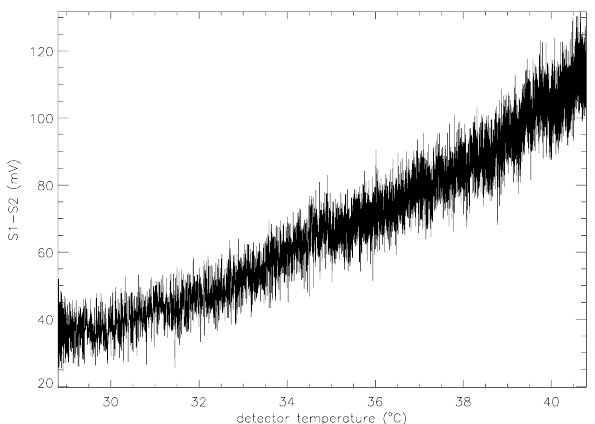
Fig. 7. The signal of the NO 2 sonde detectors as a function of the amount of NO 2 for two different versions of the detector, F05 and F07. F05 is designed for laboratory studies and is less sensitive, allowing larger NO 2 concentrations. The solid lines are linear least- squares fits.